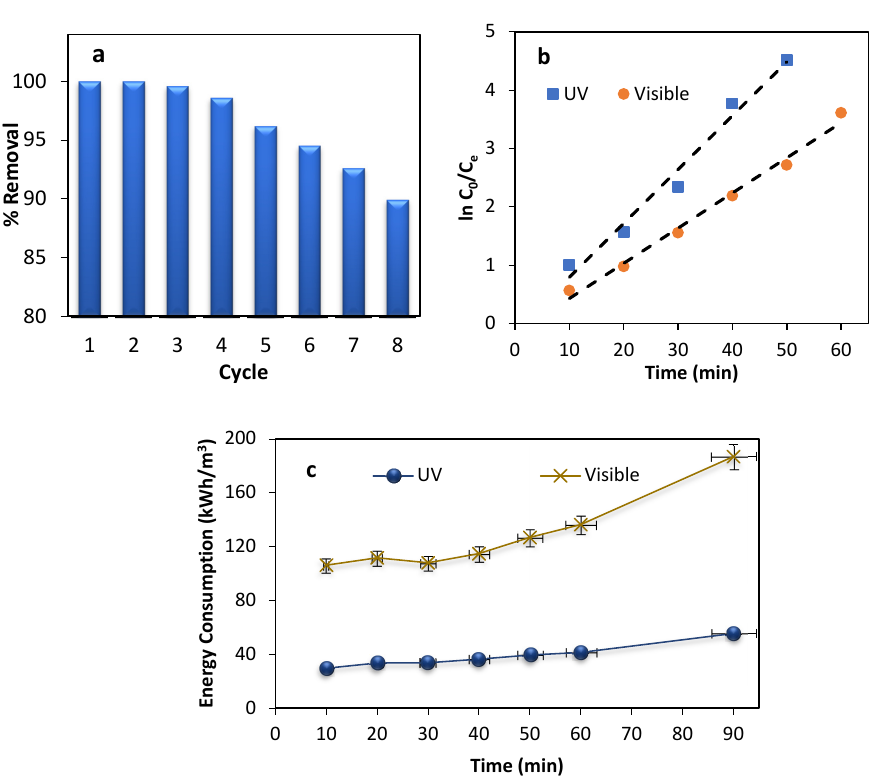
Figure 5. Results from the experiment to determine reusability ( a ), Pseudo-first-order kinetics ( b ), Energy consumed by both processes ( c ).